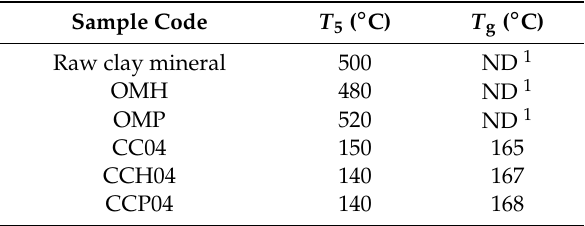
Table 3. Thermogravimetric analysis (TGA) results of the employed